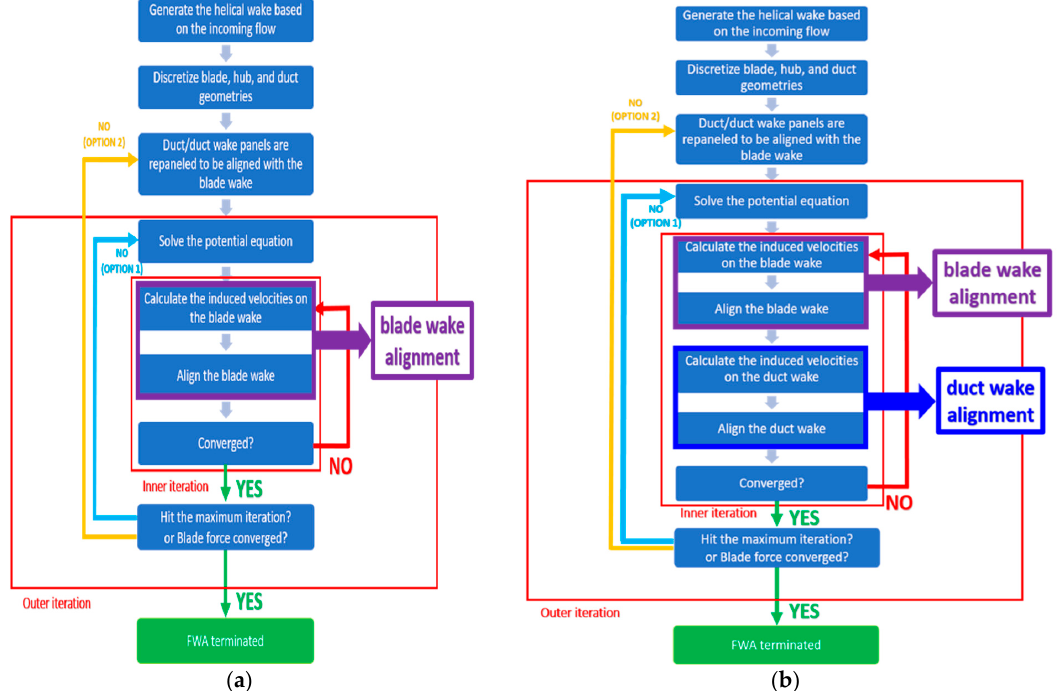
Figure 2. Flowchart of the FWA without ( a ) and with ( b ) duct wake alignment. J. Mar. Sci. Eng. 2018 , 6 , x FOR PEER REVIEW